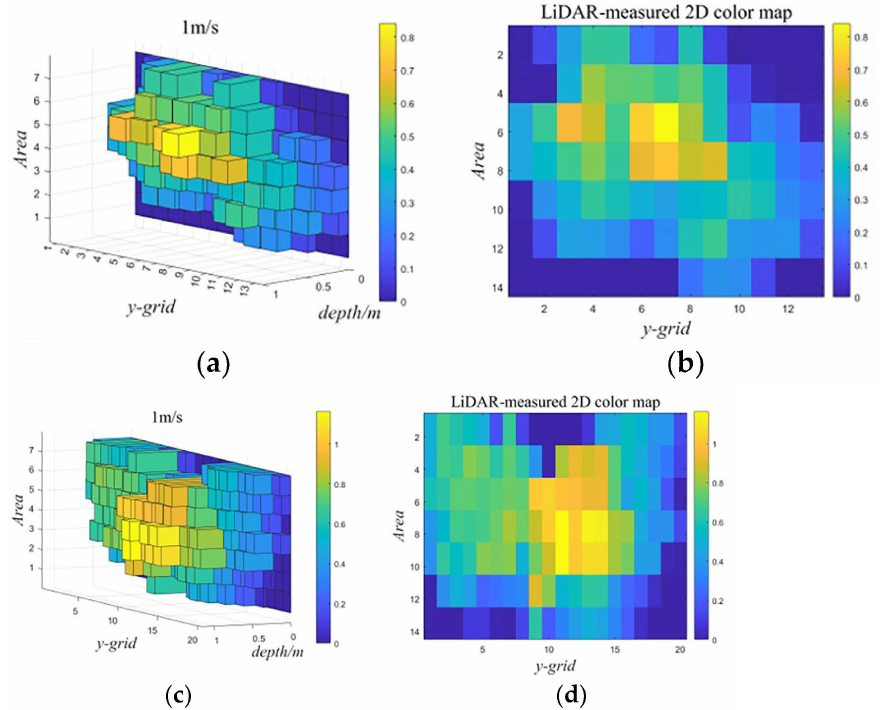
Figure 10. Colour map of the canopy thickness of Trees 2 and 3: ( a ) LiDAR-measured 3D colour map (Tree 2); ( b ) LiDAR-measured 2D colour map (Tree 2); ( c ) LiDAR-measured 3D colour map (Tree 3); ( d ) LiDAR-measured 2D colour map (Tree